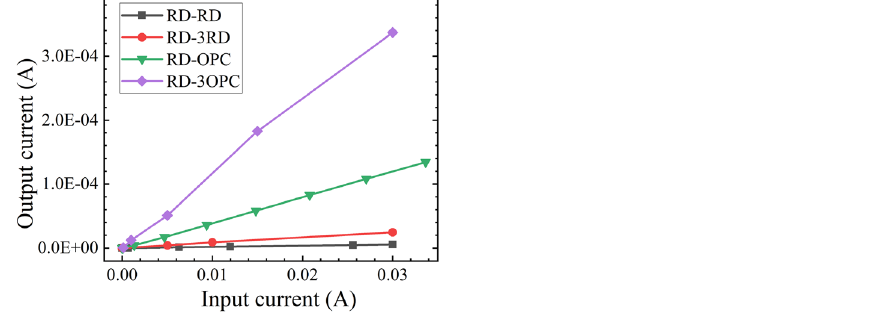
Figure 6. Optocoupler output current versus input current at 25 °C with different quantity of detectors.